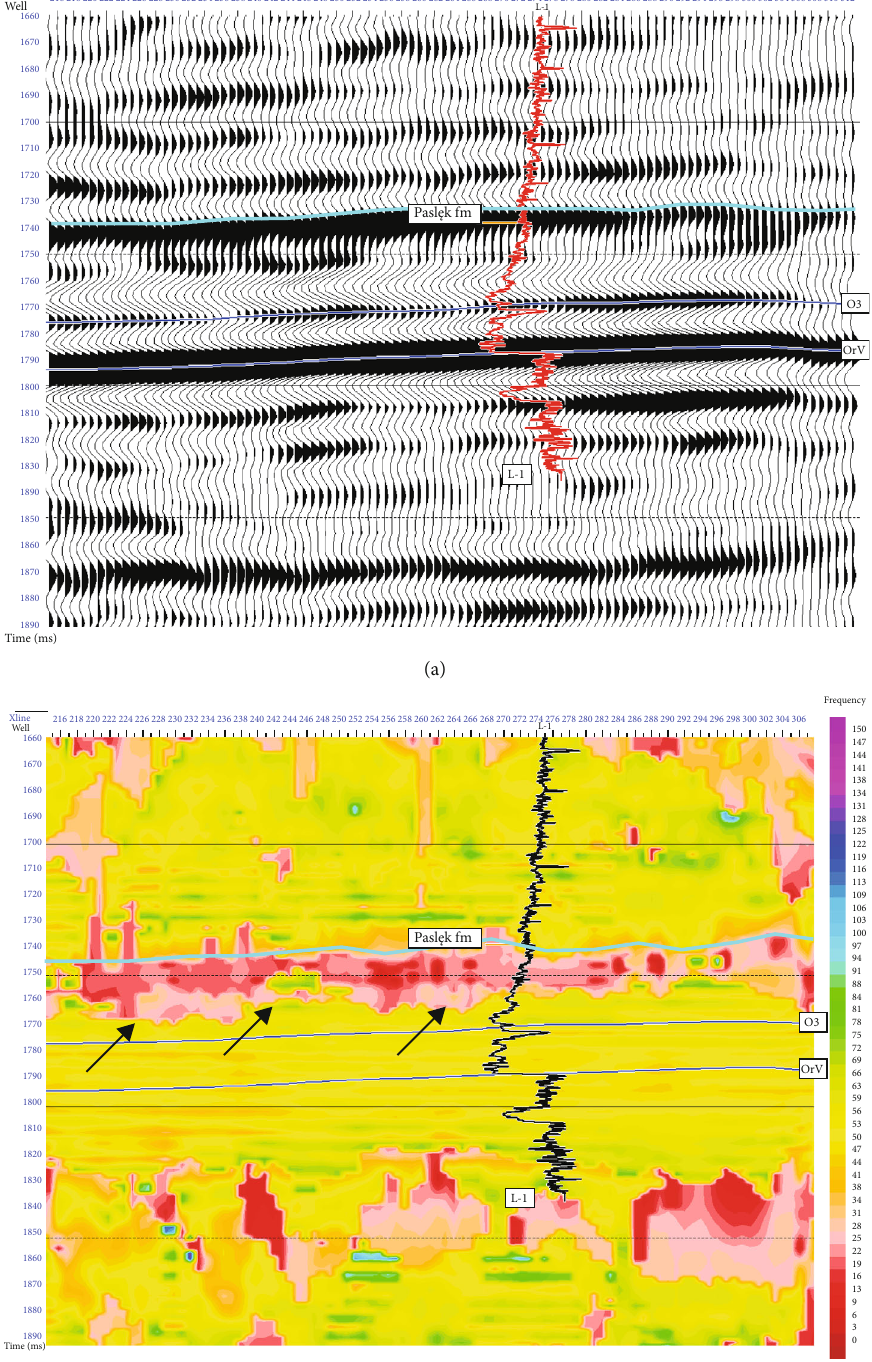
Figure 11: Zoomed seismic pro fi le that goes through the well: (a) migrated seismic section, (b) spectral decomposition based on the CEEMD algorithm. The curve is P wave velocity. In (b), red colours indicate lower frequencies, and purple indicates higher frequencies. Horizons ’ marks are O3: the top of the Prabuty formation and Orv: top of the Kopalino formation. Arrows indicate the characteristics of the low frequency anomaly (described in